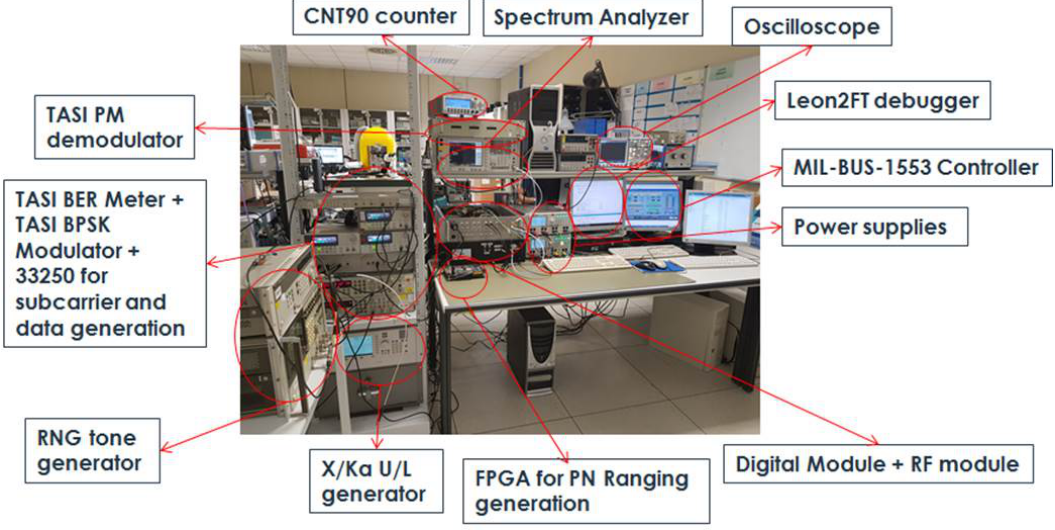
Figure 5. TAS W- ∆ DOR experimental setup.